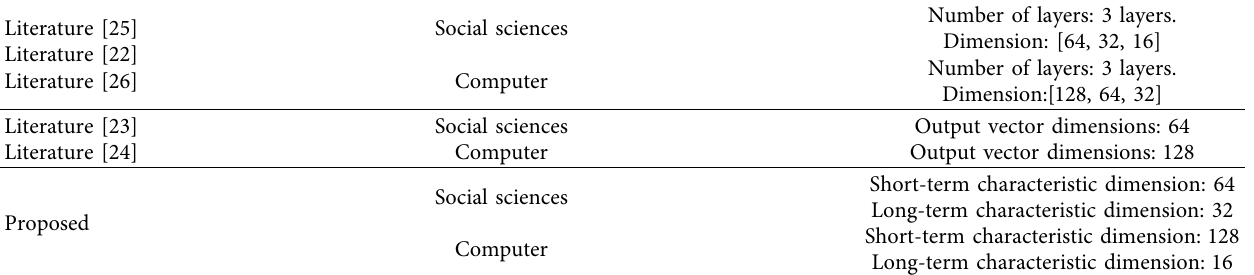
Table 3: Network parameter settings.